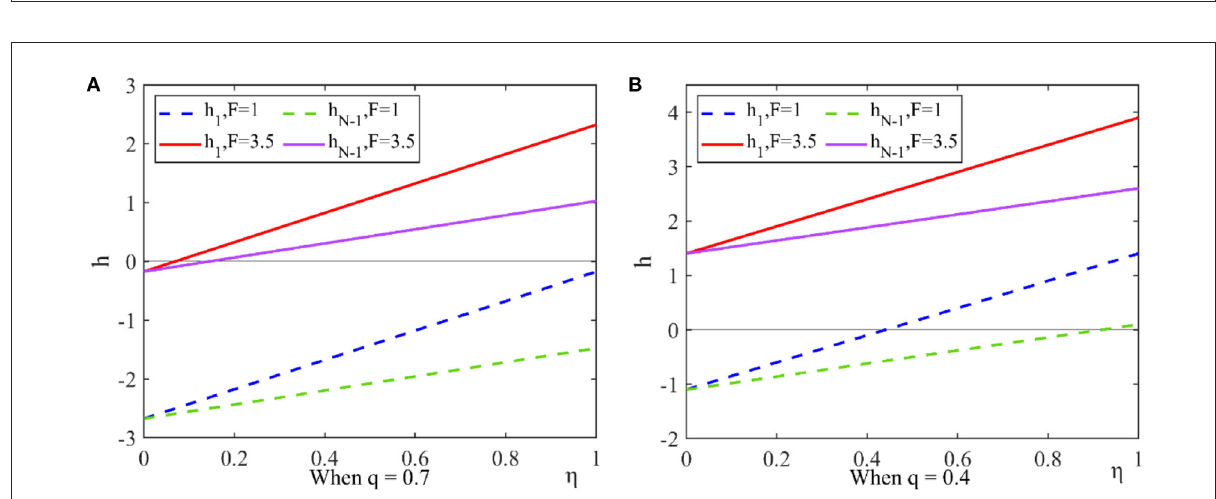
FIGURE5 Effect of government penalty and new media influence on strategic choice. This figure shows the effect of government penalty and the new media influence on the choice of drug quality improvement strategy under the dominance of expected returns. (A) When q = 0.7, (B) When q =